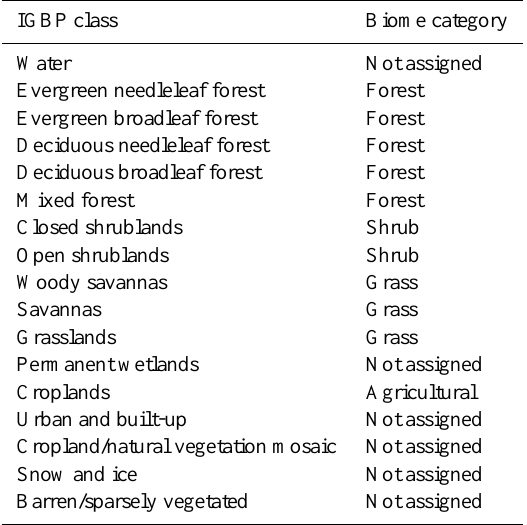
Table 1. Classification of IGBP classes to broad biome categories. IGBP